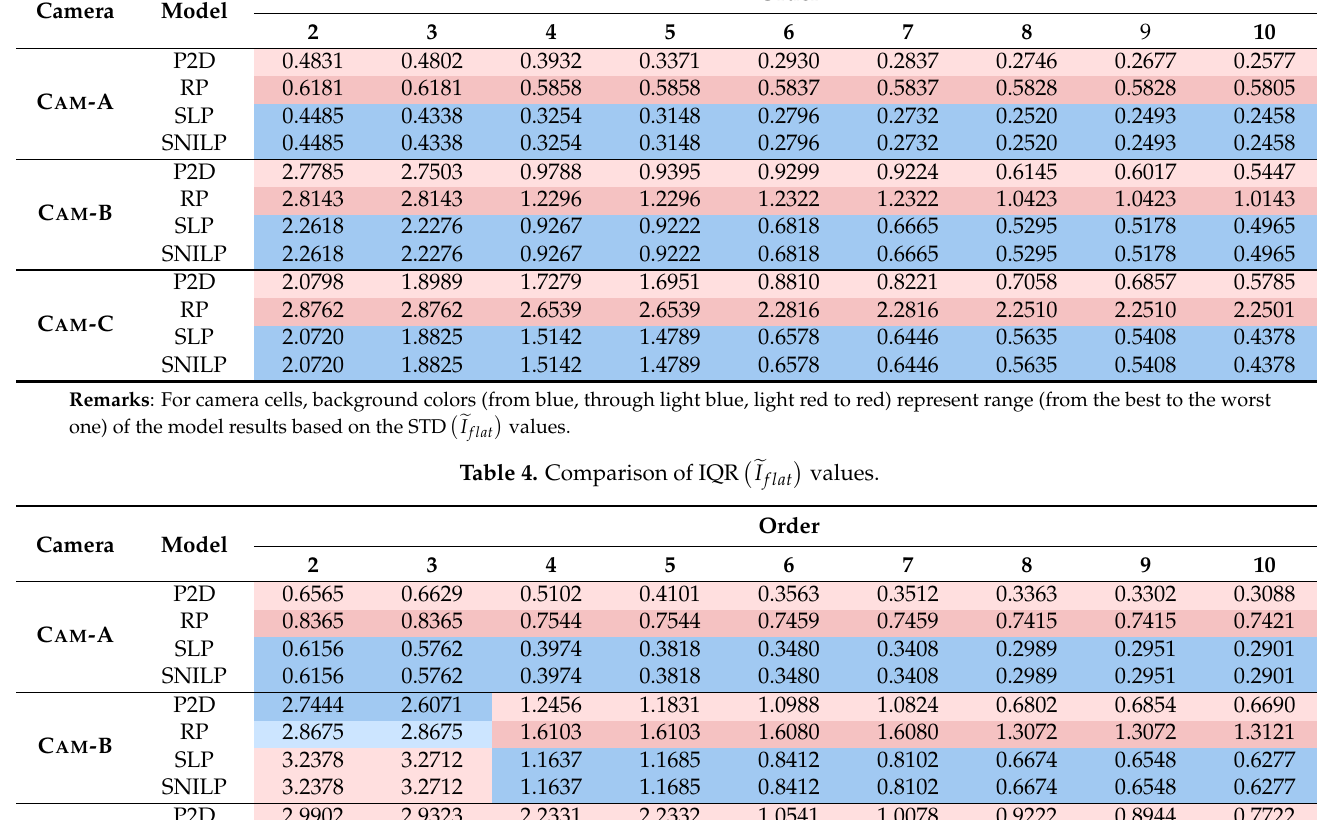
Table 3. Comparison of STD